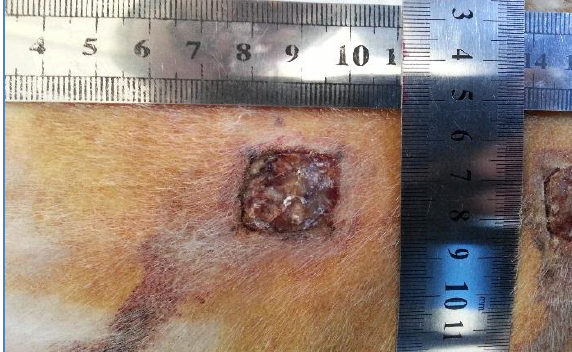
Figure, 1: The covering of wound bed of treatment group with strips of